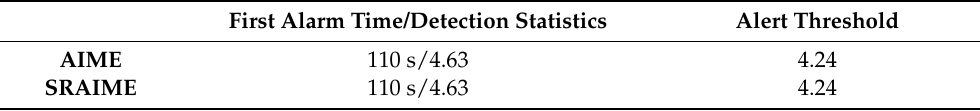
Table 1. Suntuan River Bridge statistics of AIME/SRAIME gross error detection